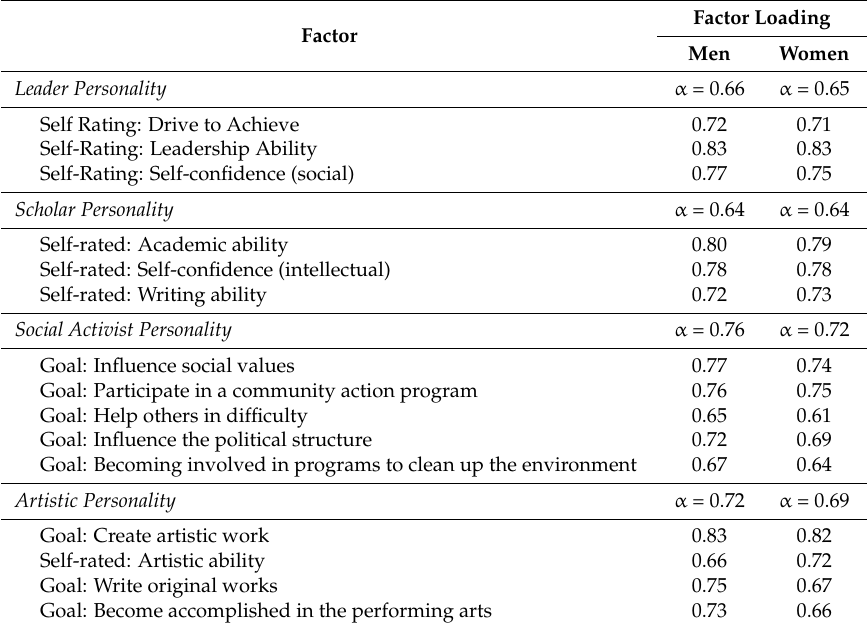
Table A2. Factor Variables, Loadings, and